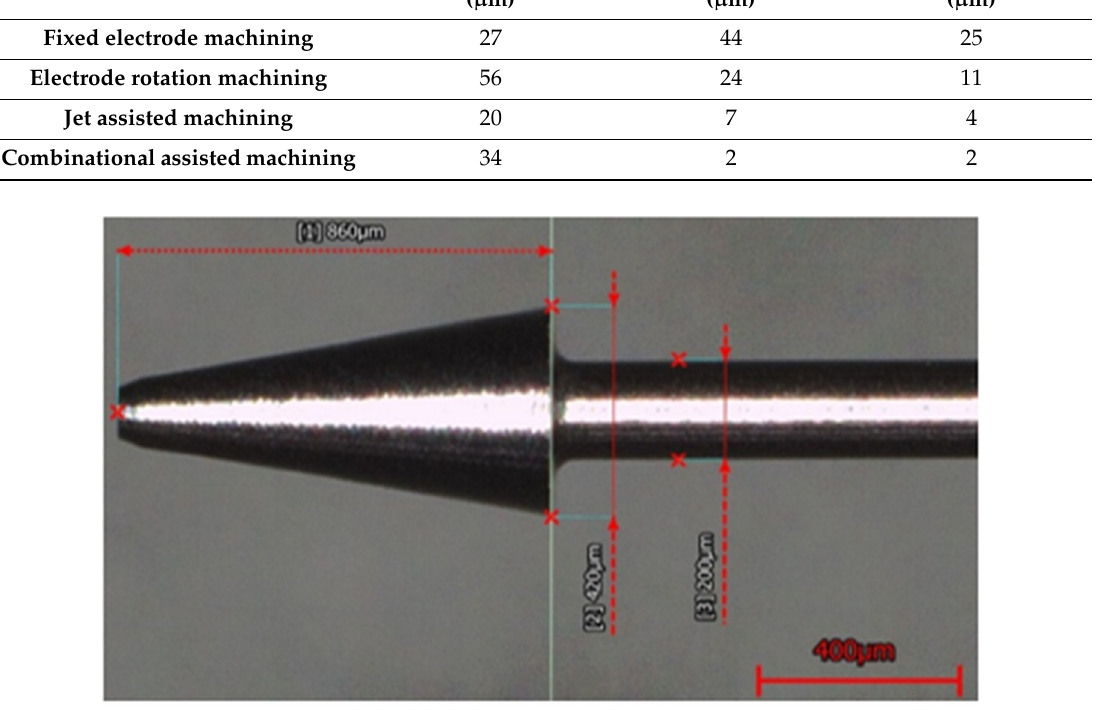
Figure 5. Schematic view of the original dimensions of the new electrode.